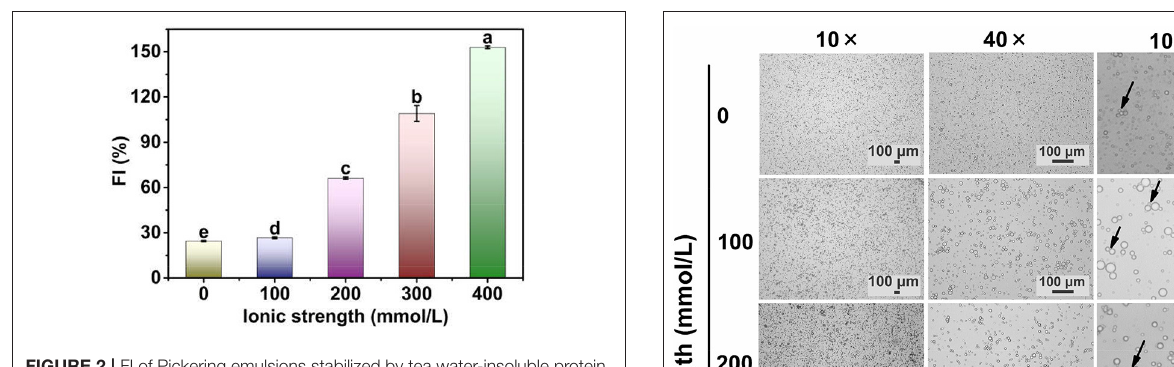
FIGURE 2 | FI of Pickering emulsions stabilized by tea water-insoluble protein nanoparticles under different ionic strengths. The lowercases indicate the significance of different Pickering emulsions by tea water-insoluble protein nanoparticles under different ionic strengths ( P < 0.05).